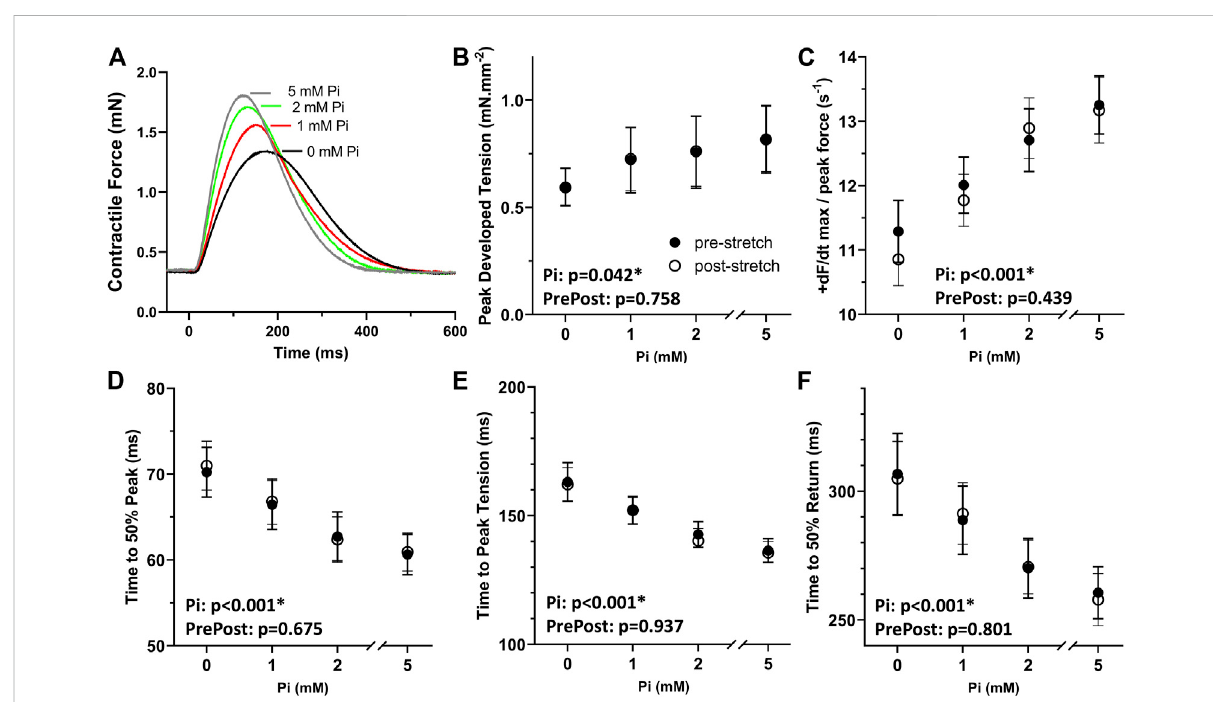
FIGURE 1 Effects of extracellular Pi on isometric myocardial force transients. (A) Examples of isometric force transients recorded at 0, 1, 2, and 5 mM extracellularPidemonstrateaPi-inducedenhancementofsystolicanddiastolicfunction. (B) Developedpeaktensionwasenhancedwithincreasing Pi. (C) Maximum rate of force increase normalized to peak force was also enhanced with increasing Pi. (D,E) Temporal characteristics of systolic function,timeto50%peakandtimetopeak,wereshortenedsigni fi cantlybyincreasingPi. (F) Timeto50%returnwassigni fi cantlyshortenedby increasing Pi thus indicating Pi-enhanced diastolic function. n = 8 rat papillary